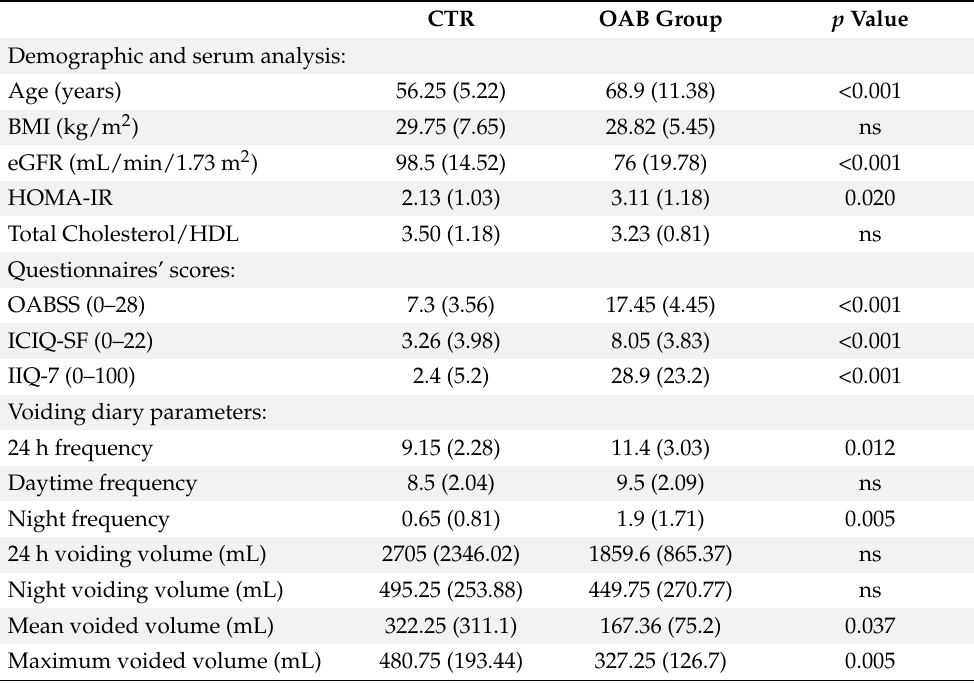
Table 1. Demographic, serum, symptom questionnaires and urine analyses data compared in the control and OAB groups. CTR OAB Group p